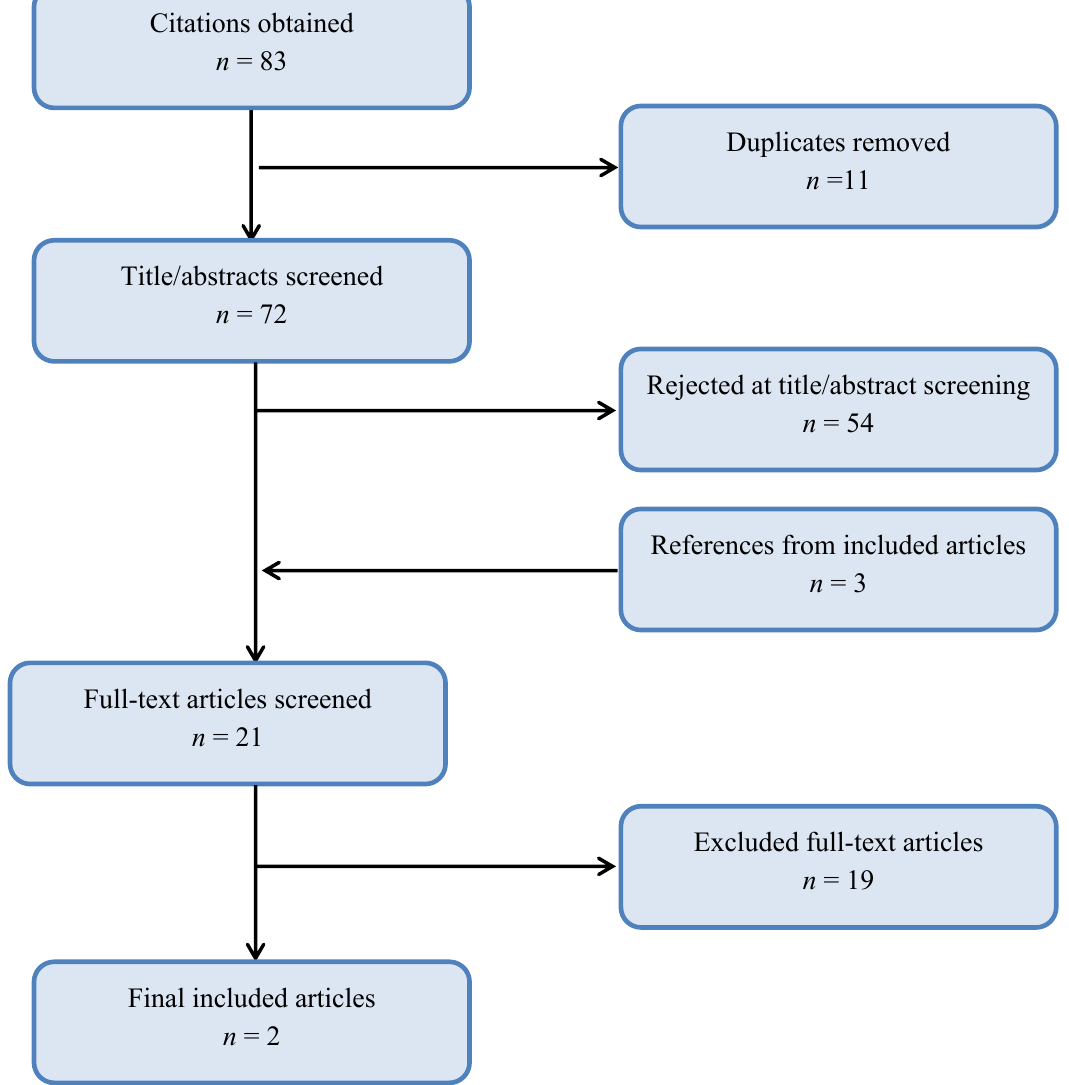
Figure 1. Flowchart of study selection (11 May 2020).